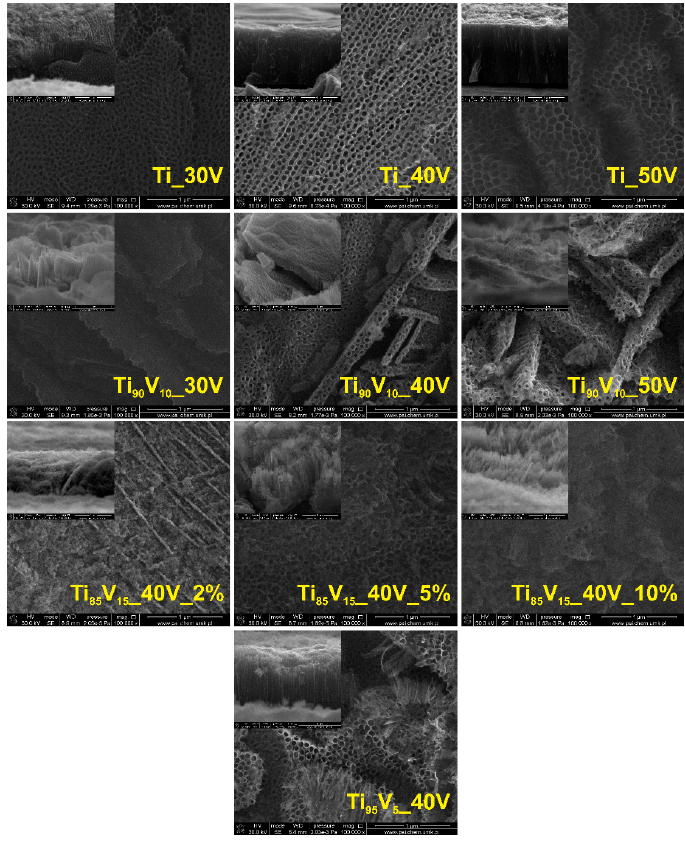
Figure 1. Top-view and cross-sectional scanning electron microscopy (SEM) images of pristine TiO 2 nanotubes (NTs) and Ti-V anodized alloys.